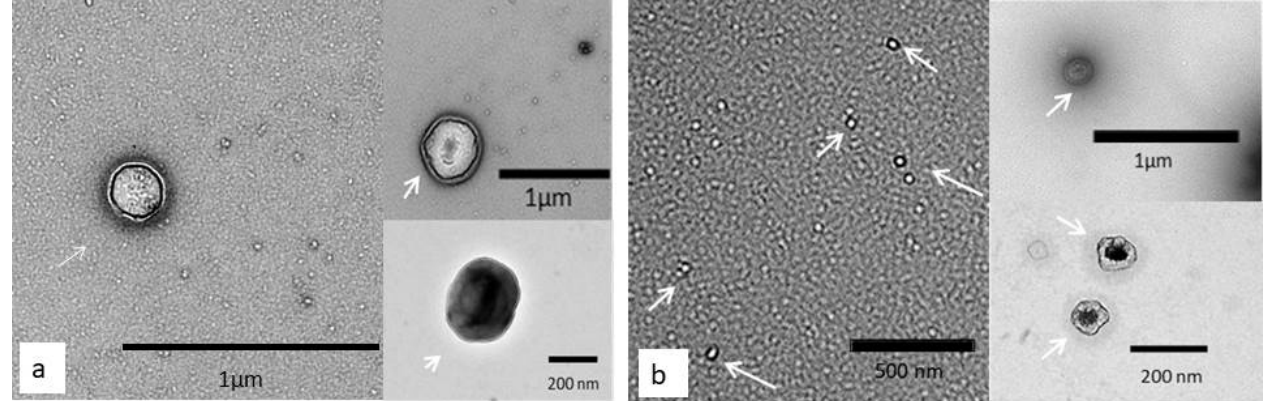
Figure 2. EVs secreted by bovine embryos during blastulation (morula to blastocyst). ( a , b ): representative images of EVs isolated from culture medium of embryos produced in vivo and vitro, respectively. Arrows are pointing identified EVs in the representative pictures.